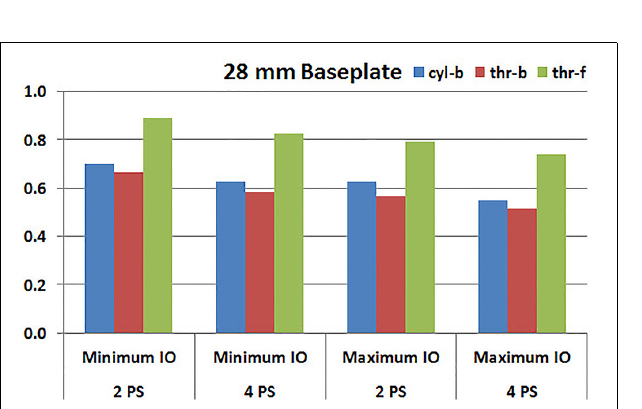
FIGURE 7 | Interfacial micromotion results of 28 mm diameter baseplate using two and four peripheral screws (2PS and 4PS); Minimum and Maximum inferior offset (Minimum IO and Maximum IO).